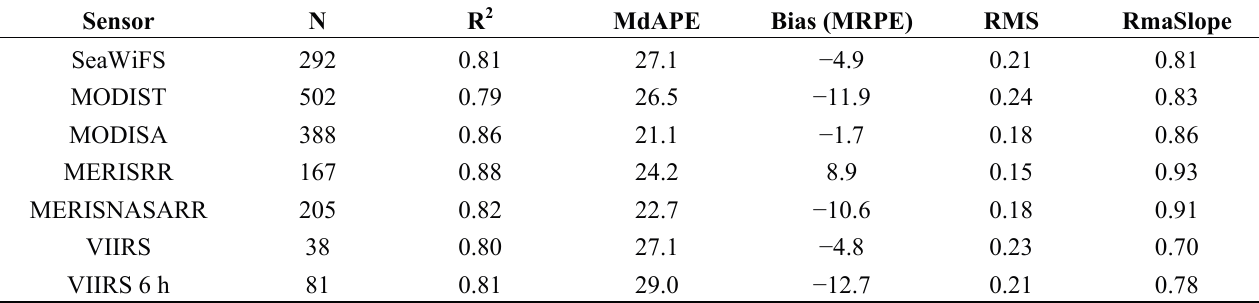
Table 2. Statistics for all match-ups with up to a 3-h time difference (also 6 h for VIIRS) and at least five valid pixels. N = number of match-ups, R 2 = coefficient of determination, MdAPE = median absolute percent error, Bias = median relative percent error, RMS = Root Mean Square error, RmaSlope = slope of the reduced major axis linear regression. MERISRR, standard ESA processed algal_1 product; MERISNASARR, the NASA processed chlor_a